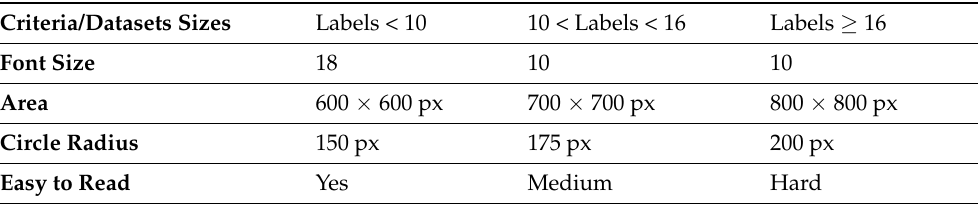
Table 5. Evaluation criteria of user perceptions using